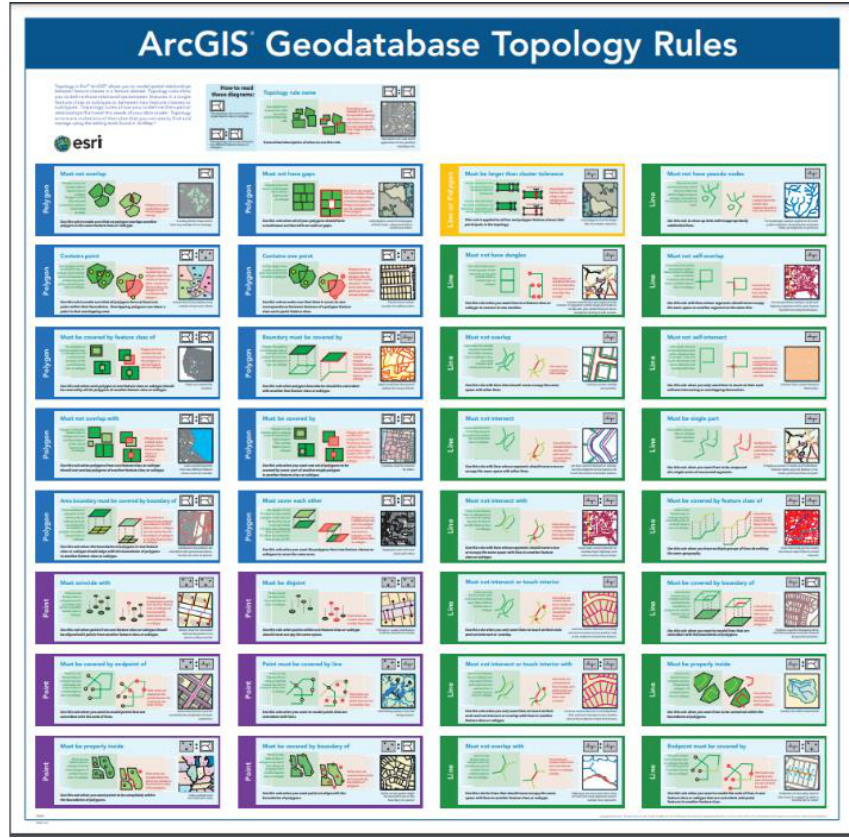
Figure 1. ArcGIS geodatabase topology rules (ESRI, 2010).